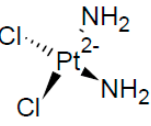
Figure 2. Cisplatin structure.